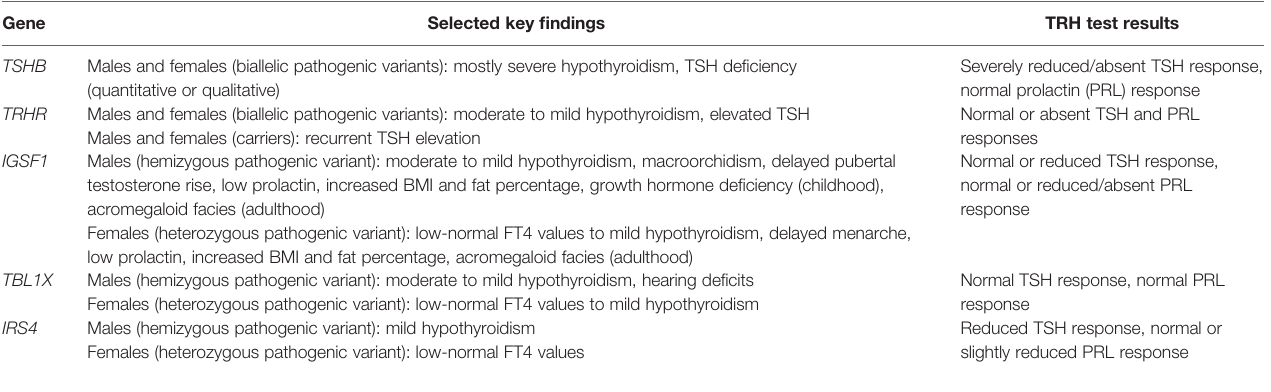
Selected key fi